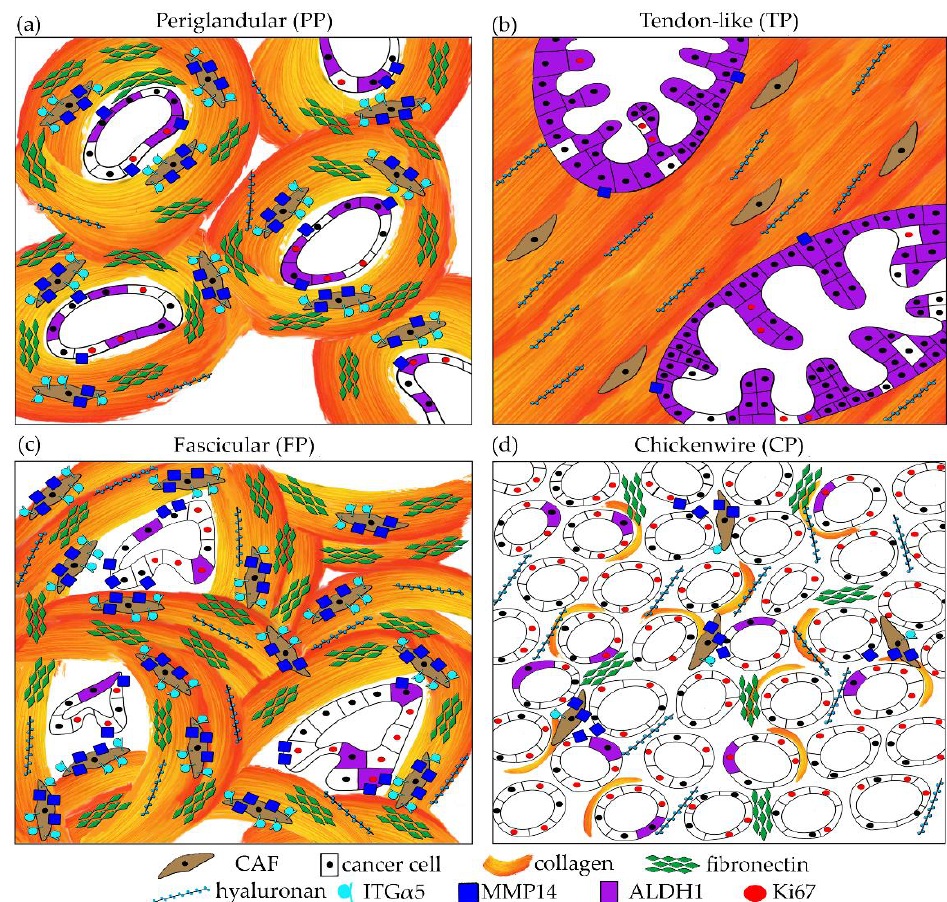
Figure 5. Four patterns of pancreatic cancer with distinctive morphological, structural and functional features of the cancer-cell and stromal compartments. ( a ) In the periglandular pattern, the stromal sheath that encircles the tumor glands contains a moderate amount of CAFs and is rich in fibronectin and MMP14, produced by both CAFs and PCCs. The latter show moderate expression of ALDH1 and Ki67. ( b ) The tendon-like pattern has a collagen- and hyaluronan-rich stroma that is devoid of fibronectin and shows marked fiber alignment. The majority of cancer cells express ALDH1. Note the low levels of MMP14 and Ki67. ( c ) The whorled stroma of the fascicular pattern contains a high number of CAFs with high expression of ITG α 5 and marked deposition of aligned fibronectin. Note the high-level expression of MMP14 in stroma and PCCs. ( d ) The small stromal compartment in the chickenwire pattern is relatively rich in hyaluronan but contains little collagen and fibronectin and lacks fiber alignment. CAFs are low in number. Note the high Ki67-expression in the PCCs. ALDH1, aldehyde dehydrogenase 1; CAF, cancer-associated fibroblast; ITG α 5, integrin α 5; MMP14 matrix metalloproteinase 14; PCC, pancreatic cancer